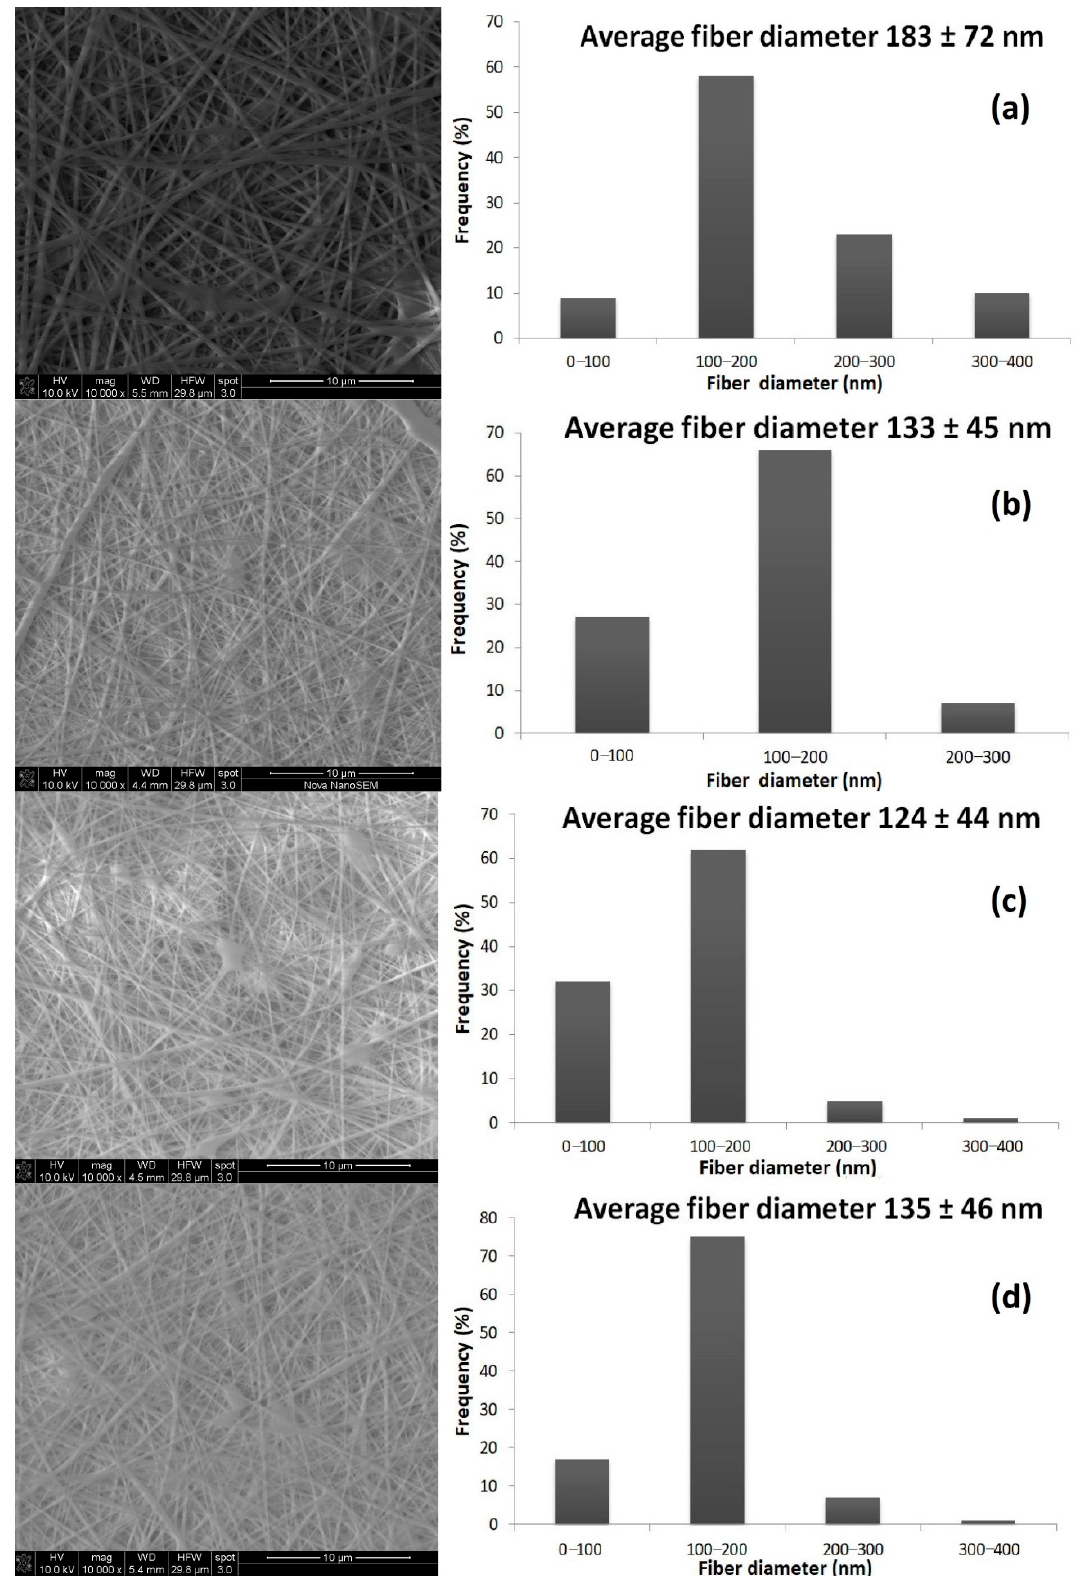
Figure 3. SEM images and fiber diameter distributions of the electrospun SA/PVA fibers obtained from ( a ) SA/PVA, ( b ) 1BP-SA/PVA, ( c ) 2BP-SA/PVA, and ( d ) 3BP-SA/PVA ( ×